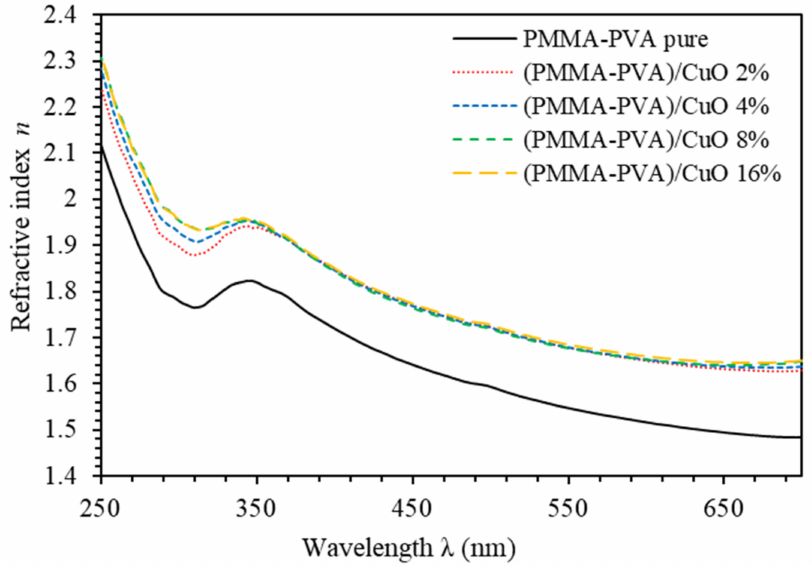
Figure 4. Refractive index spectra of PMMA–PVA/CuO nanocomposite thin films as a function of wavelength for various CuO NPs concentrations.